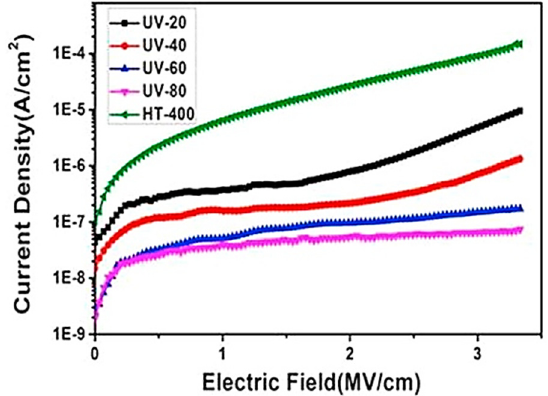
Figure 11. Comparison of leakage current in ZrO 2 films after annealing by UVO and high-temperature (HT) [92]. Reprinted with permission from [92]; 2017 Elsevier.